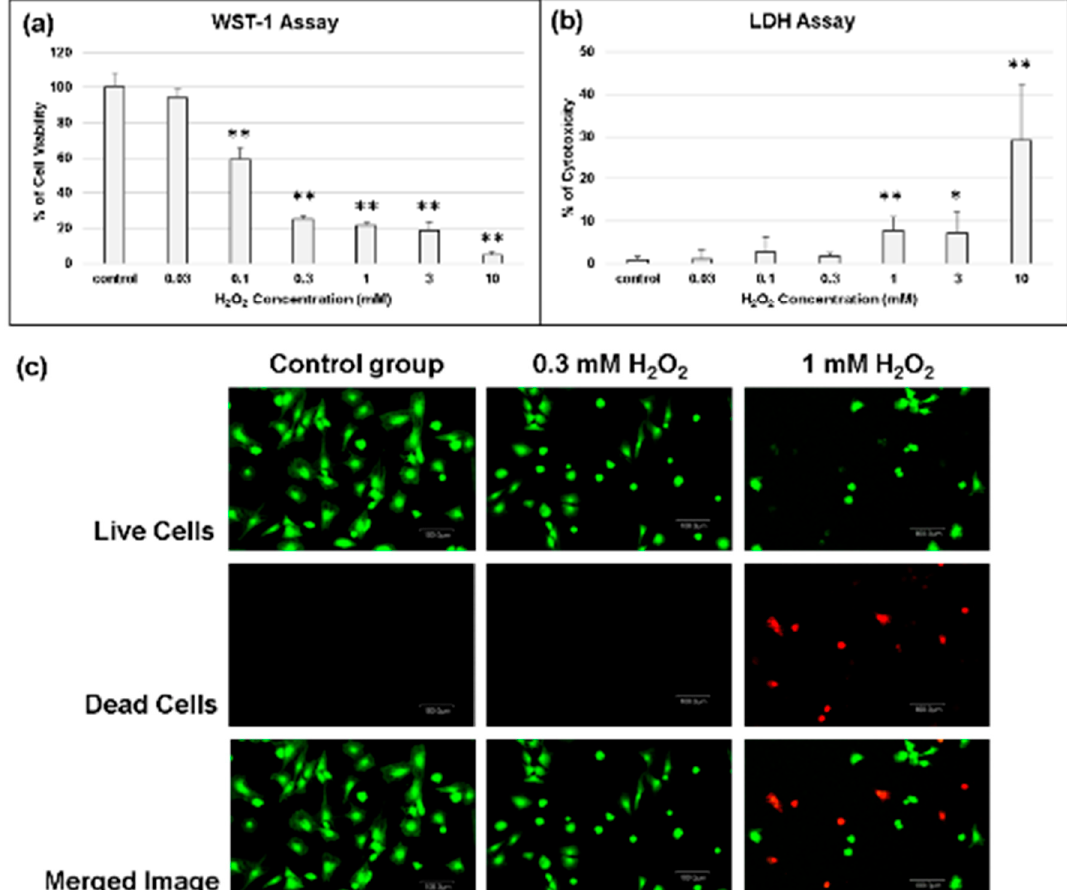
Figure 3. Determination of chondrocytes viability under oxidative stress. ( a ) Water-soluble tetrazolium (WST-1) assay; ( b ) Lactate dehydrogenase (LDH) assay; ( c ) Live/dead staining of chondrocytes under different concentration of H 2 O 2 treatment for 30 min. * P < 0.05 and ** P < 0.01 when compared with th control group.